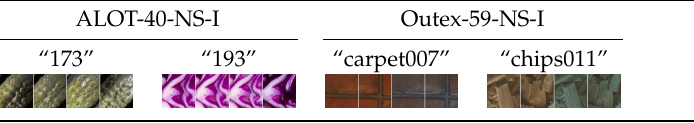
Figure 4. Group #4: Non-stationary textures acquired under variable illumination (Section 3.2.4).